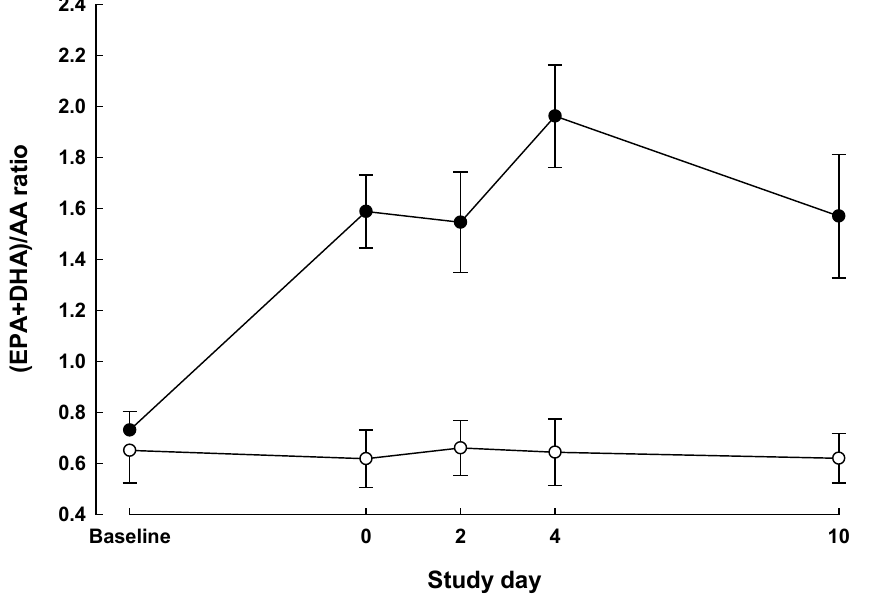
Figure 1. Plasma phosphatidylcholine (PC) (eicosapentaenoic acid (EPA) plus docosahexaenoic acid (DHA))/arachidonic acid (AA) ratio (mean ± SEM) measured at baseline, day of surgery and on postoperative days 2, 4 and 10 in patients who received Impact preoperatively and postoperatively (immunonutrition (IMN) n = 4, solid symbols) compared with patients who received no preoperative supplemental nutrition and Isosource postoperatively (standard treatment (STD) n = 4, open symbols).